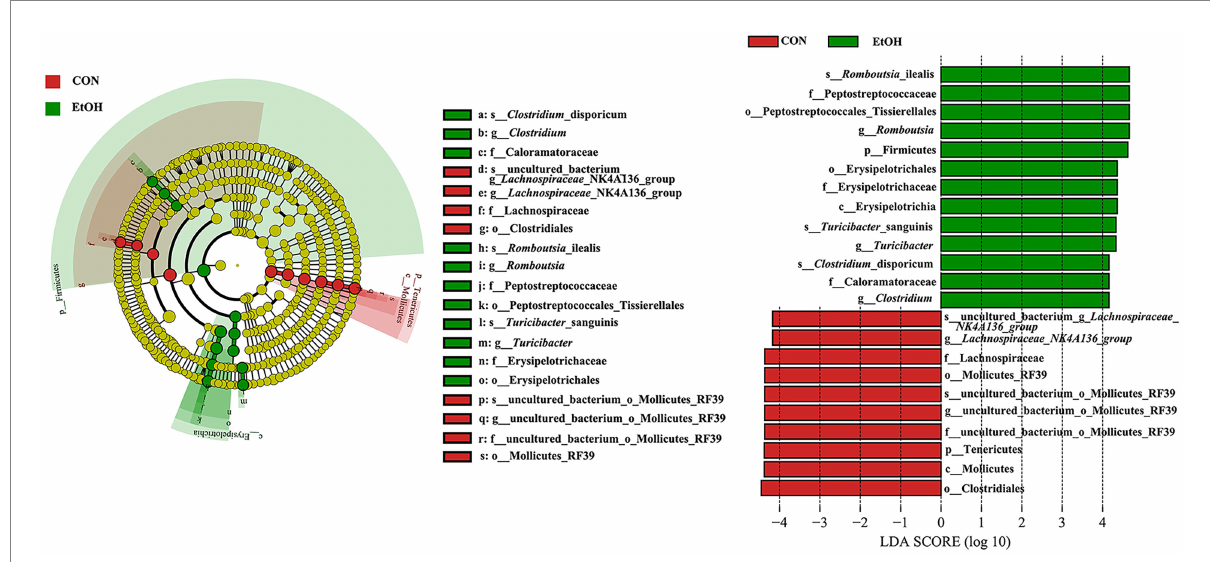
FIGURE 5 Linear discriminant analysis Effect Size (LEfSe) analysis between the EtOH and CON groups, with a LAD score > 4.